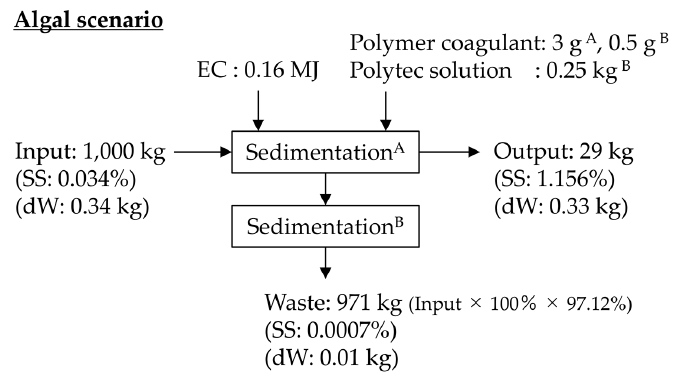
Figure 5. Mass balance of microalgae oil production in flocculant sub-unit per 1 m 3 .